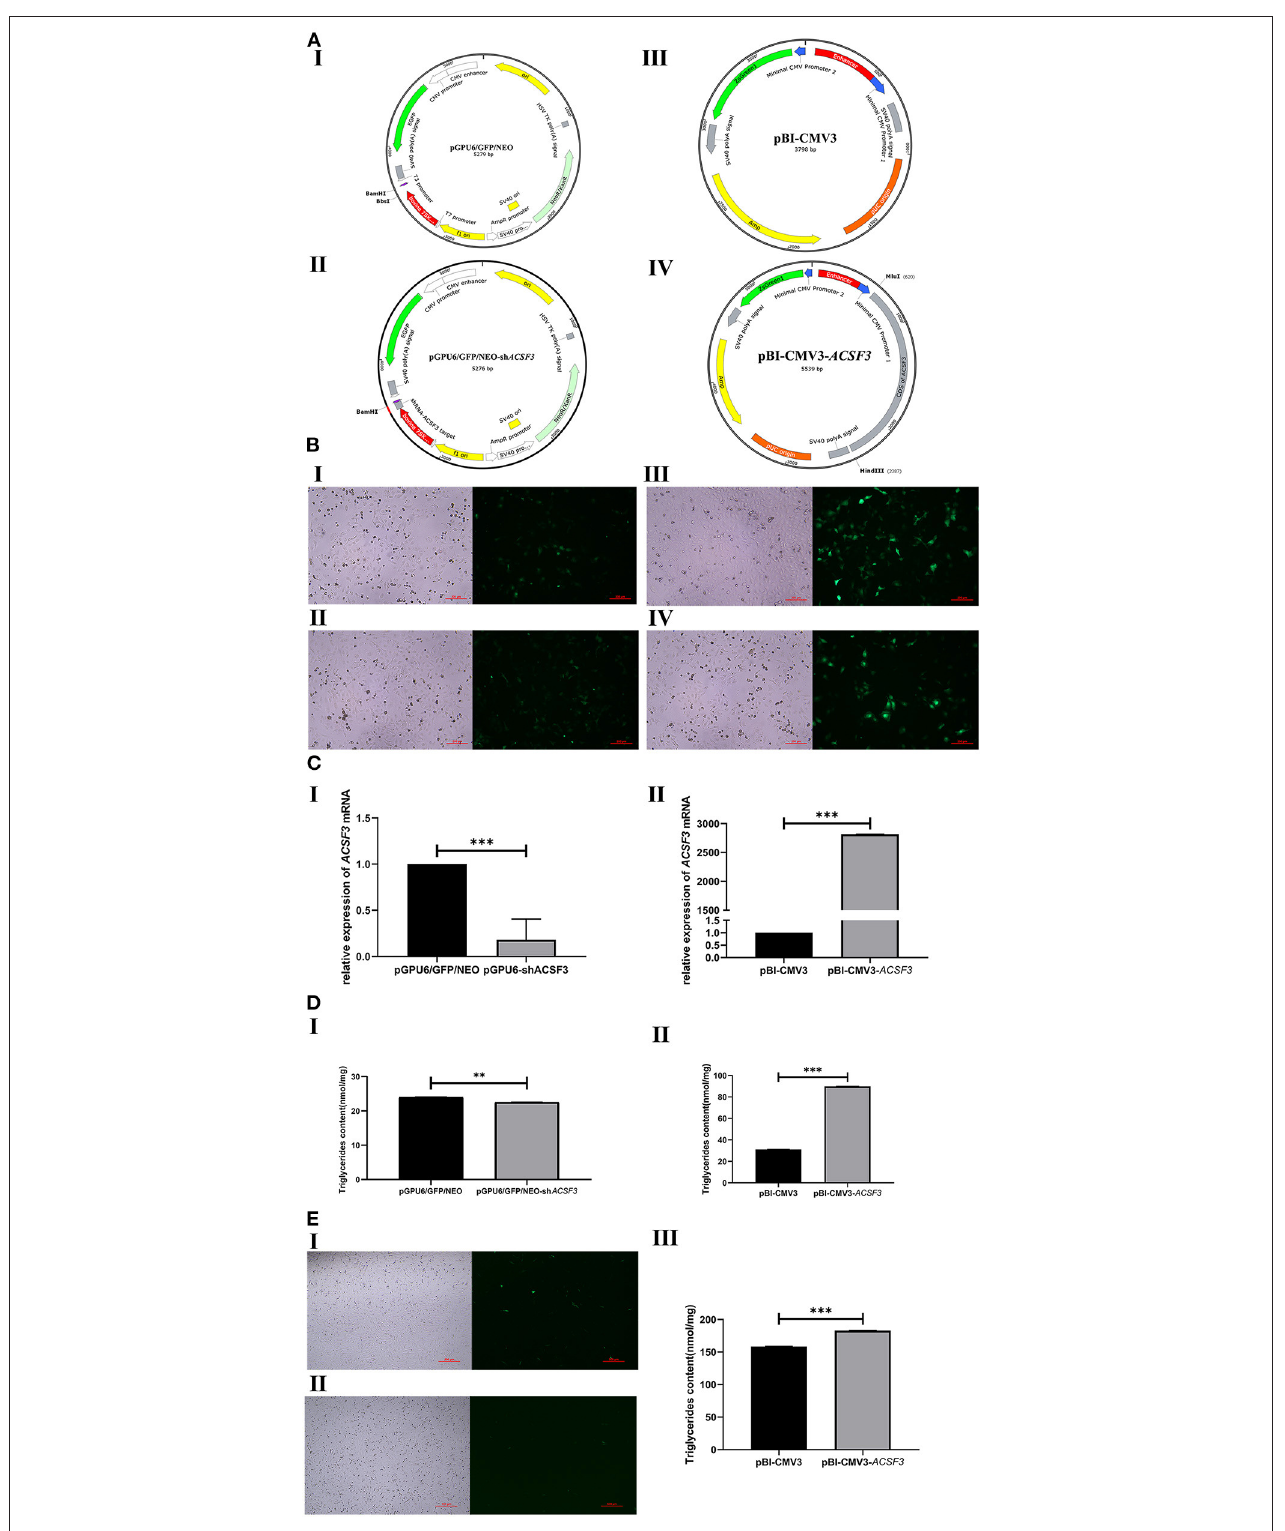
FIGURE 2 | Effect of ACSF3 gene interference or overexpression on triglyceride synthesis of transfected cells. (A) The maps of vectors used in this study including size. I: Control vector for RNA interference of ACSF3 gene (pGPU6/GFP/NEO); II: RNA interference vector of ACSF3 gene (pGPU6/GFP/NEO-sh ACSF3 ); III: Control for ACSF3 gene over-expression vector (pBI-CMV3); IV: ACSF3 gene over-expression vector (pBI-CMV3- ACSF3 ). (B) Expression of green fluorescence protein was